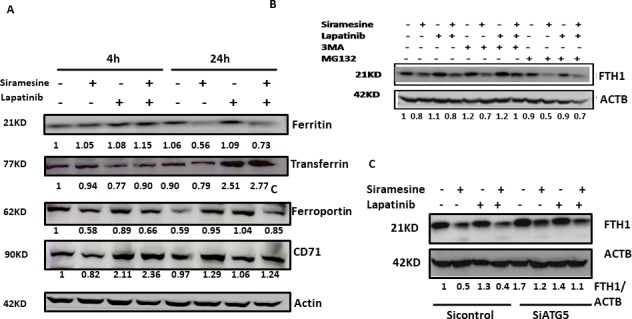
Autophagy promotes ferritin degradation following siramesine and lapatinib treatment in MDA MB 231 cells.(A) MDA MB 231 cells were lysed after treatment with DMSO (D), siramesine (S), lapatinib (L) and siramesine and lapatinib (S + L) for 4 and 24 hour. Western blot determination of iron-related proteins ferritin (FTH1) transferrin, transferrin receptor (CD71), ferroportin (FPN) was performed. Actin was used as a loading control. (B) The effects of 3-MA (2mM) and MG132 (1 microM) on expression level of FTH1 following siramesine and lapatinib treatment in MDA MB 231cells for 24 hours respectively. Before treatment under siramesine and lapatinib, cells were pretreated with 3mM and MG132 for 1hour. (C) Effects of knockdown of Atg5 on siramesine and lapatinib-induced FTH degradation at 24 hour in MDA MB 231 cells.